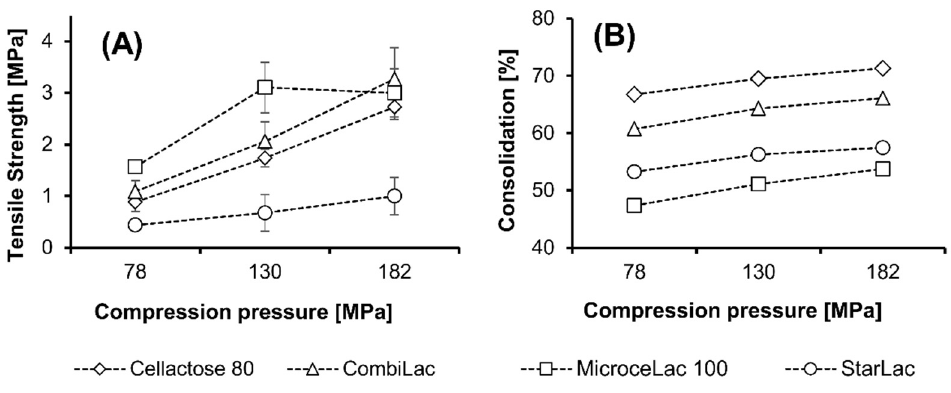
Figure 7. Tensile strength ( A ) and consolidation behavior ( B ).